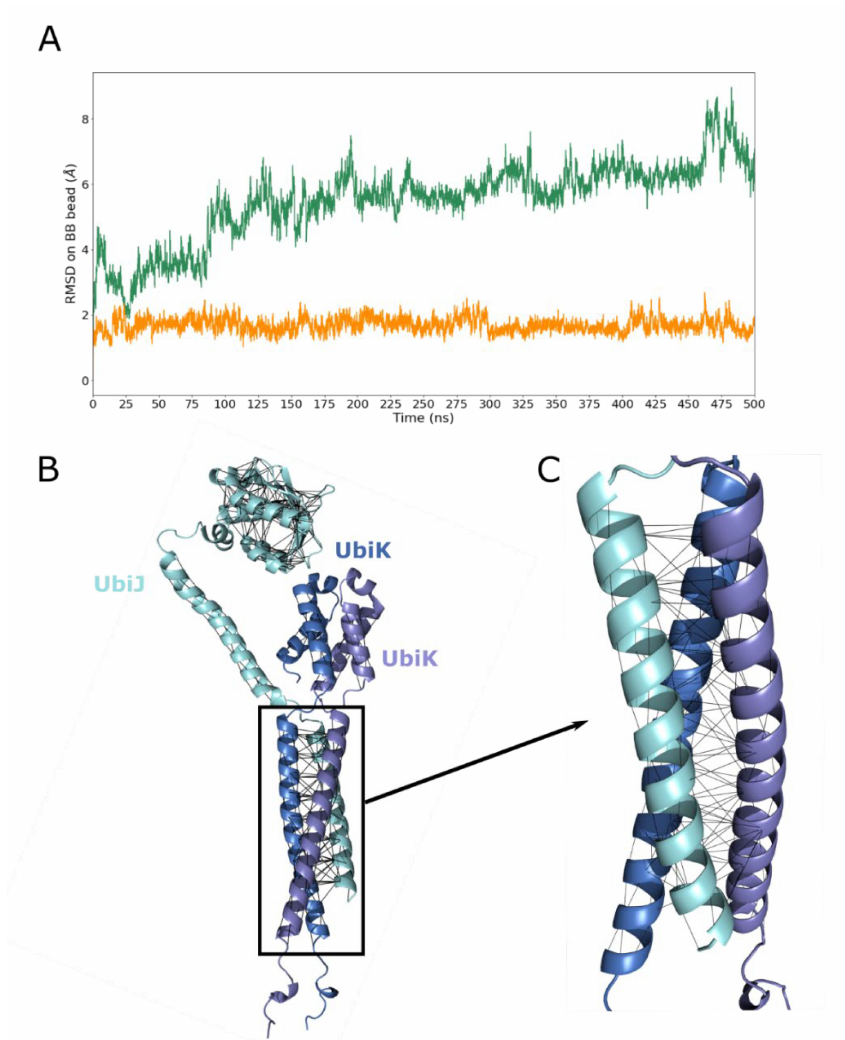
Figure 7. Heterotrimer stability in solution using CG MD simulation. ( A ) RMSD based on the CG backbone beads (BB) is plotted as a function of MD time (ns) for only intra-chain Go-like model (green) and adding inter-chain Go-like model (orange). The RMSD fit was done on BB beads of the coiled-coil region, which is defined by residues 171–201 for UbiJ and 49–85 for two chains of UbiK. The first frame of the MD production was used as reference for RMSD calculations RMSD on the backbone beads on 500 ns of AF2 model with and without G¯o-like model ( B ) AlphaFold2 heterotrimer shown in cartoon with the used G¯o-like model in black lines. ( C ) Enlarged view of the G¯o-like model on the coiled-coil